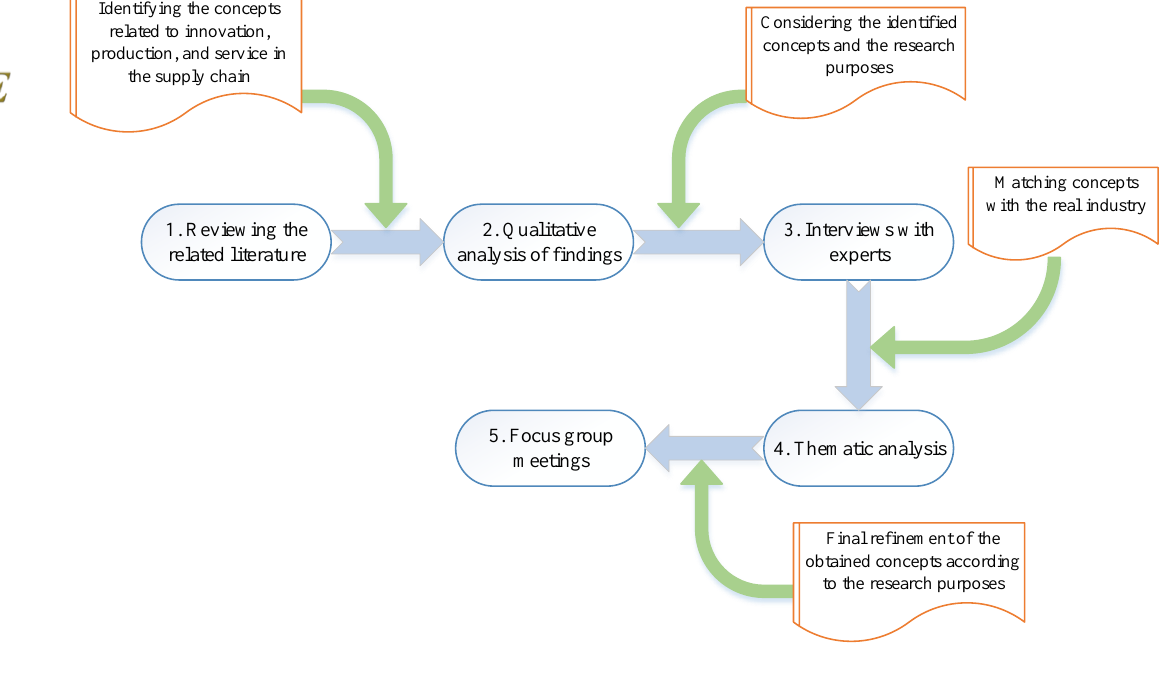
Fig. 2. The methodology of this